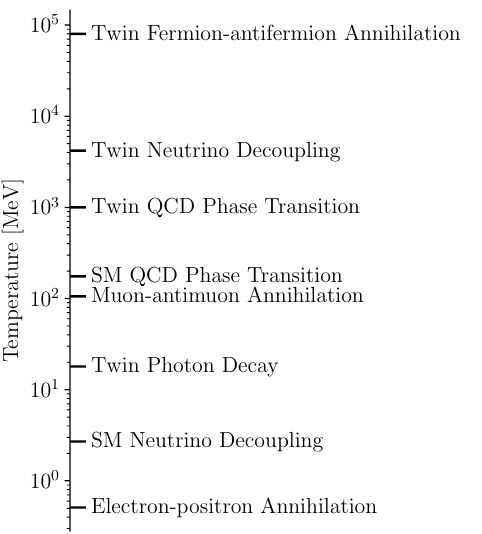
Figure 1 . An example cosmic timeline of events in this model that impact observations of N e(cid:11)